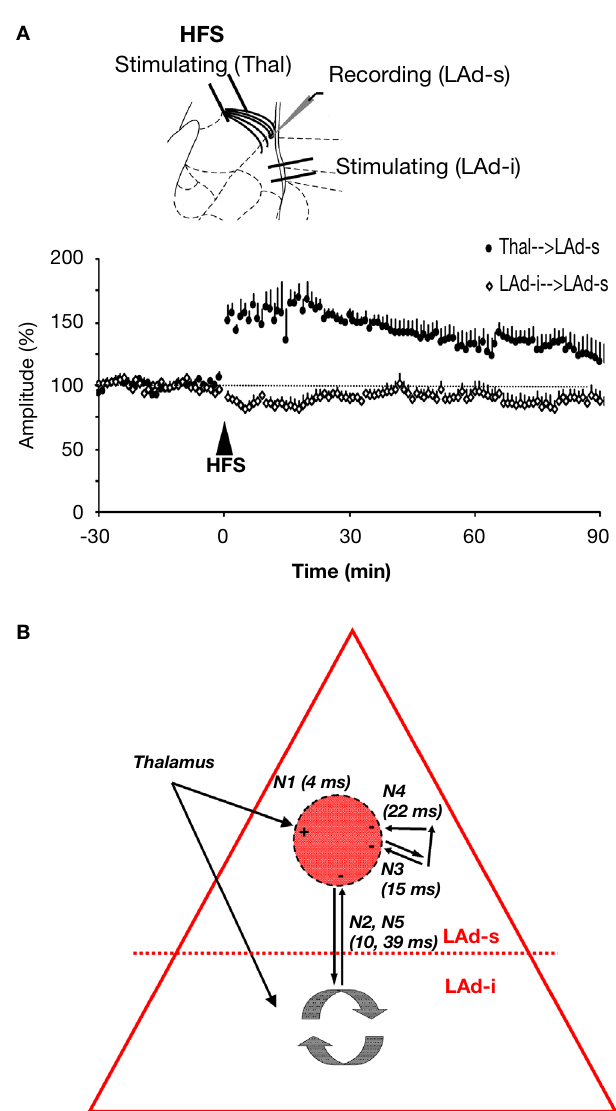
Figure 9 | Polysynaptic activity in LAd-s originates from recurrent activity and is plastic. (A) Induction of thalamo-amygdala LTP induced LTD at intra- network LAd-i to LAd-s afferents. Both LTP and LTD lasted for at least 90 min. (B) Schematic model of the temporally structured and plastic recurrent network in LAd. The model describes the temporal sequence of polysynaptic excitatory activity mapped in the LAd-s in vitro , evoked by activation of the thalamic- amygdala path. The excitatory model is described in the absence of the GABA network of Samson and colleagues (2003). The activity of the model is described in “Network time”, as measured relative to the presynaptic conductivity prior to N1 activation (i.e. fi ber volley, FV). Stimulation of thalamic fi bers activates a monosynaptic connection in the LAd, which synchronizes polysynaptic activities (TLPs). Next, polysynaptic activation occurs via a network of LAd axon collaterals which pro- vide an opportunity for network activity to infl uence proceeding amygdala afferent input. The fi rst polysynaptic activity to occur (N2, 10 ms after FV in vitro ) is direct ventro-dorsal and dorso-ventral connectivity (di-synaptic). This connectivity is an excitatory recurrent feedback connection to LAd-s. Further polysynaptic activity occurs via multisynaptic connectivity within the LAd-s (N3, N4). Our slice reduction data showed a further ventro-dorsal recurrent feedback from LAd-i to LAd-s (N5, 39 ms), which may well be resulting from N6 in the LAd-i. The model also incorporates functional aspects of the network. Monosynaptic LTP at thalamo-amygdala synapses ( + ) results in suppression of polysynaptic feedback synapses ( − ) on the same population of cells [see (A)